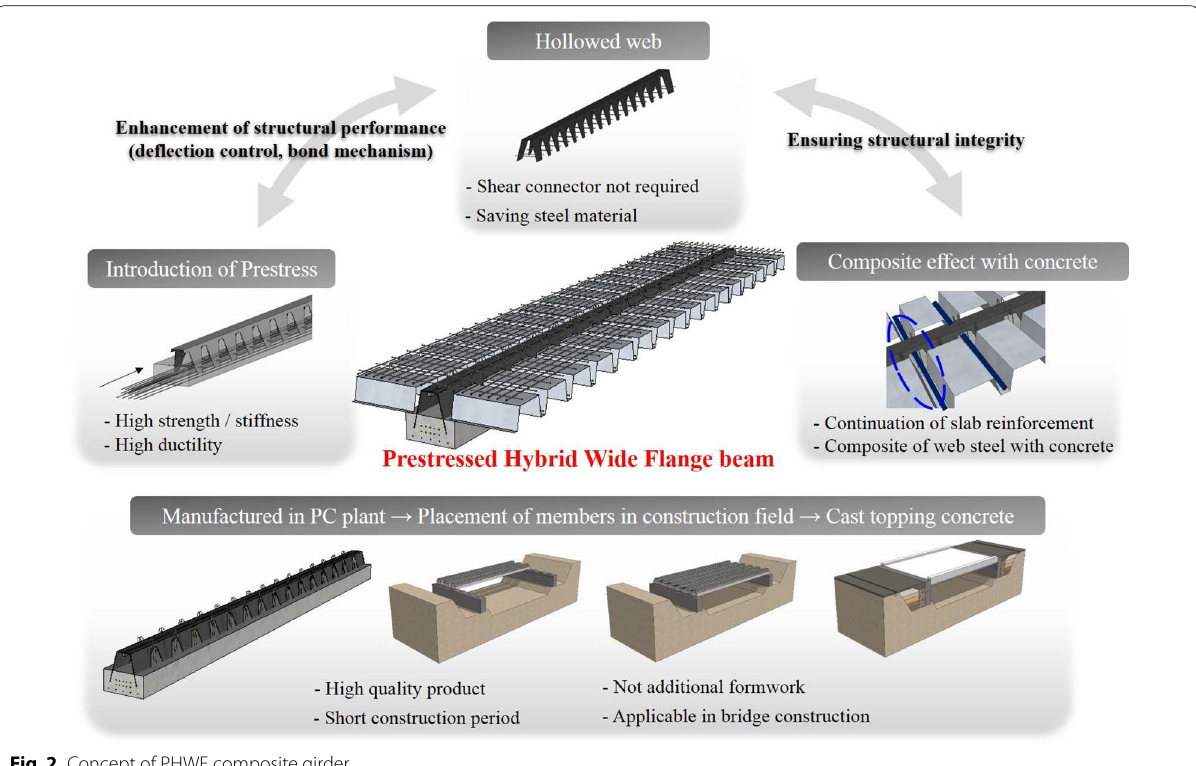
Fig. 2 Concept of PHWF composite